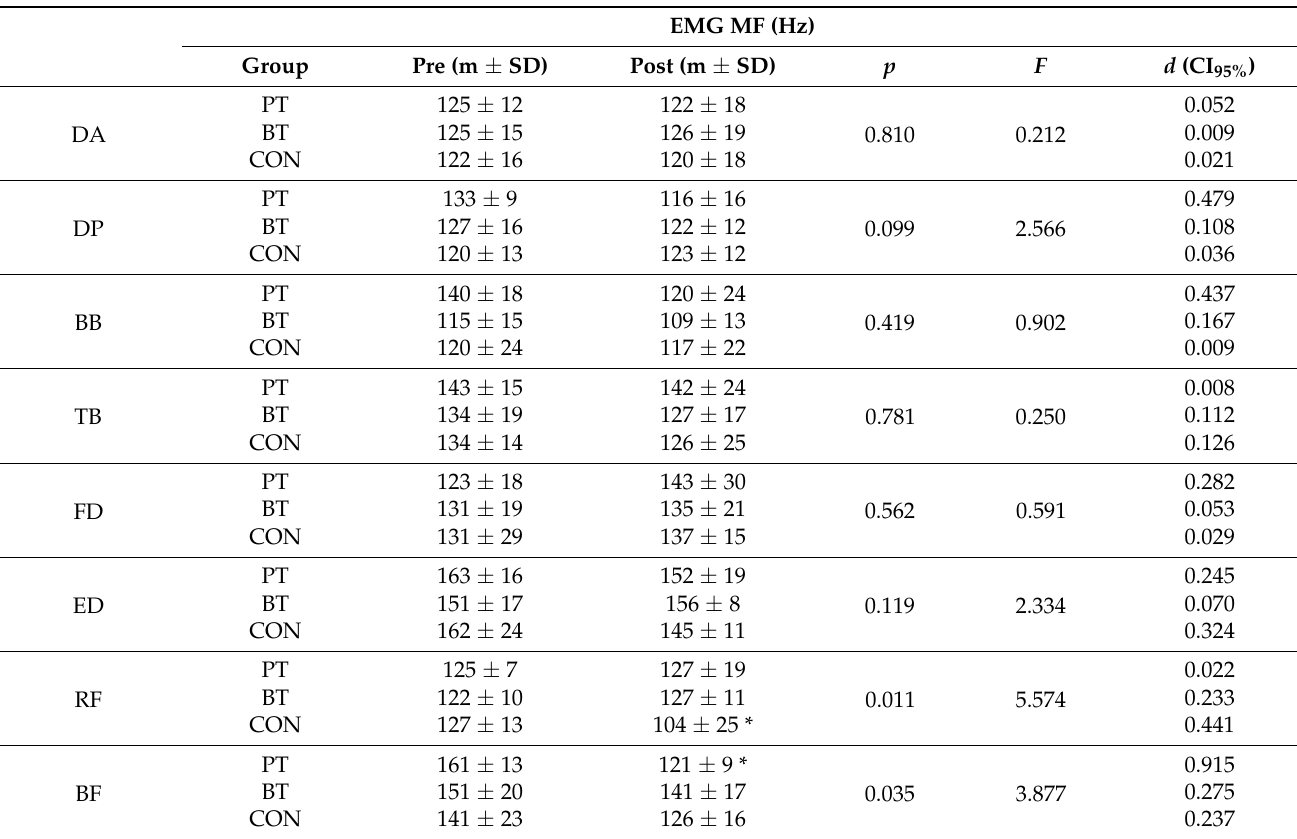
Table 5. Changes in the EMG mean frequency (MF) in each muscle during the maximum muscle excitability test after the 8-week